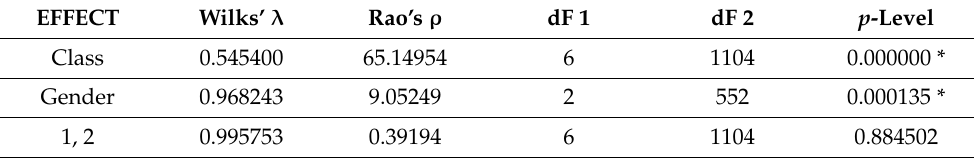
Table 2. General evaluation of the sample.